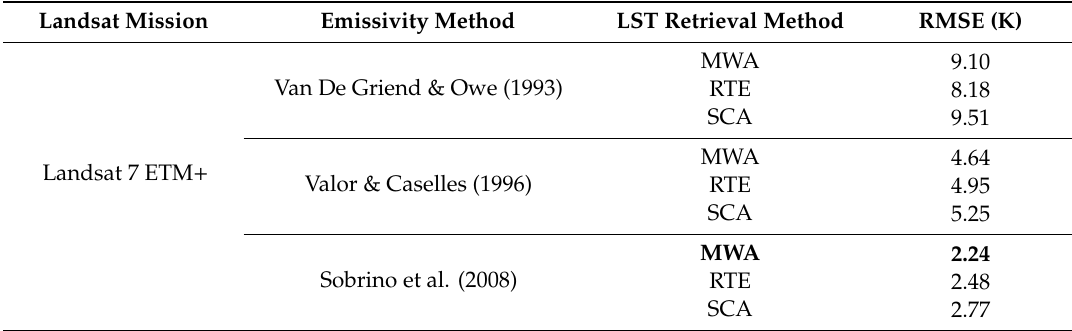
Table 6. Validation results of LST retrieval methods for Landsat 7 ETM + data based on di ff erent LSE models. The best result is in